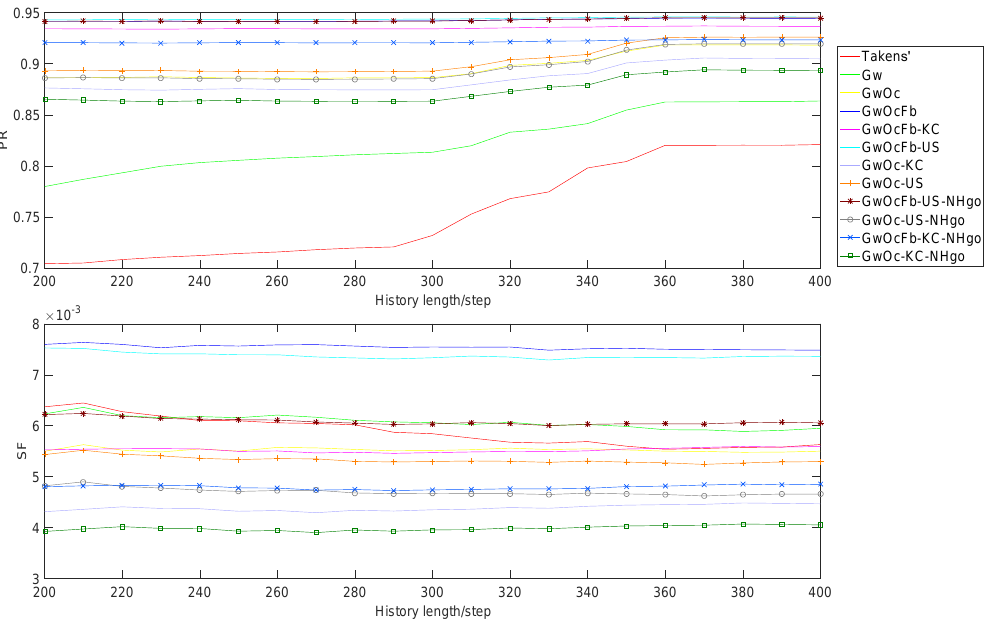
Figure 8. Influence of history data length used in embedding vector generation (left hip joint data in the sagittal plane). SF : smoothness factor; PR : prediction ratio.